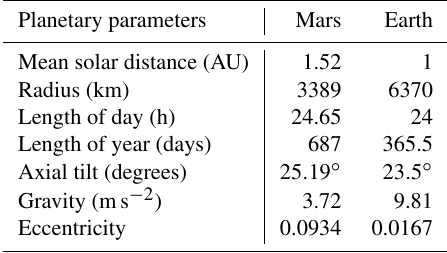
Table A1. Some key planetary parameters of Earth and Mars. Planetary